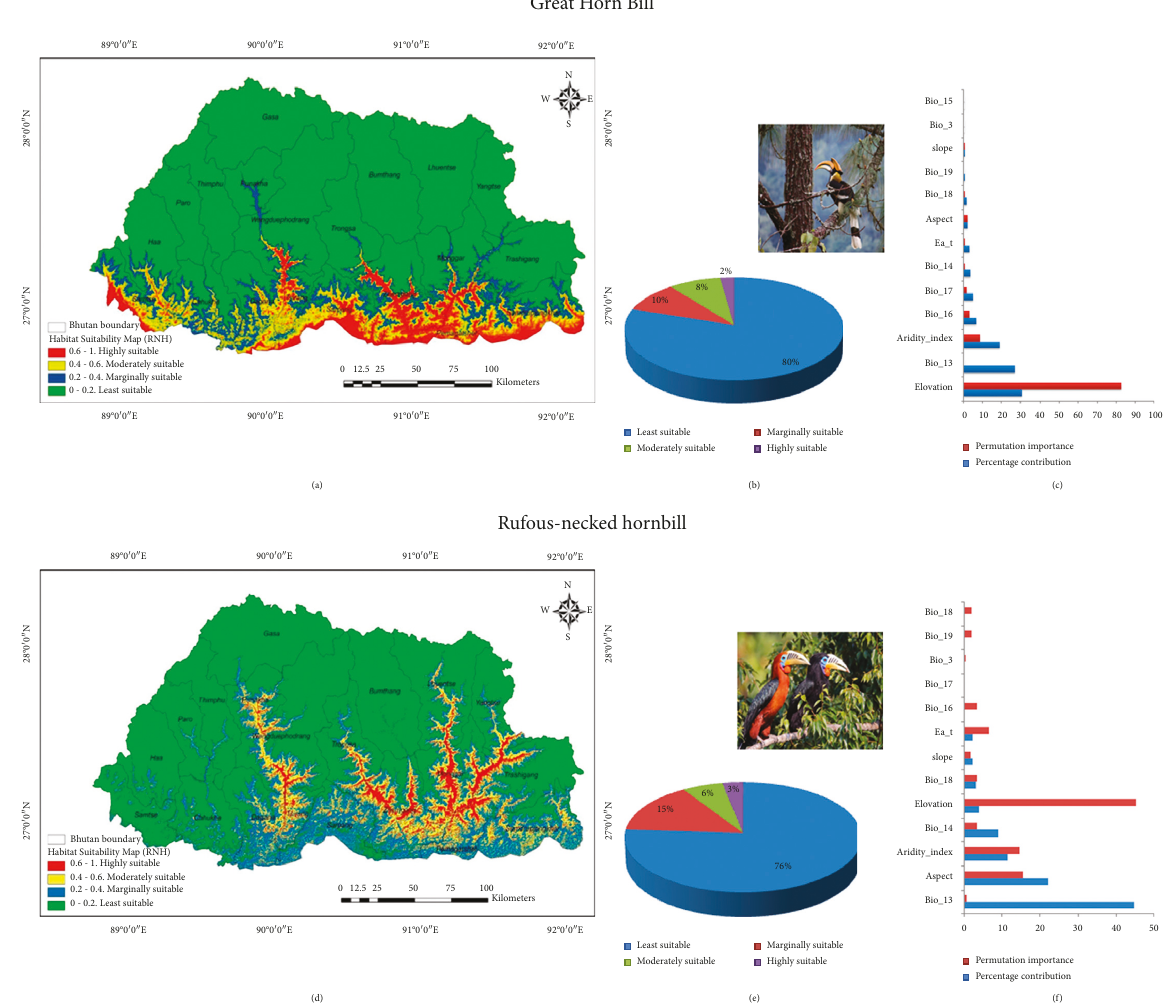
Figure 3: Habitat suitability map of GH and RNH with percentage of area suitability for species and permutation importance of con- tributing